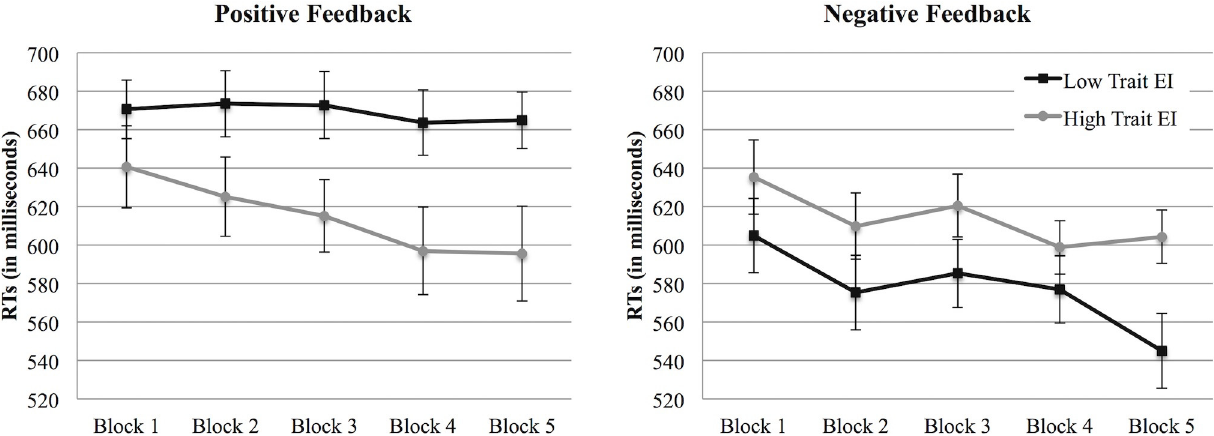
Fig 9. Reaction times (Study 2). Reaction times in the negative (left panel) and in the positive (right panel) feedback conditions across the 5 blocks for low and high trait EI participants. Error bars indicate 1 standard error above or below the